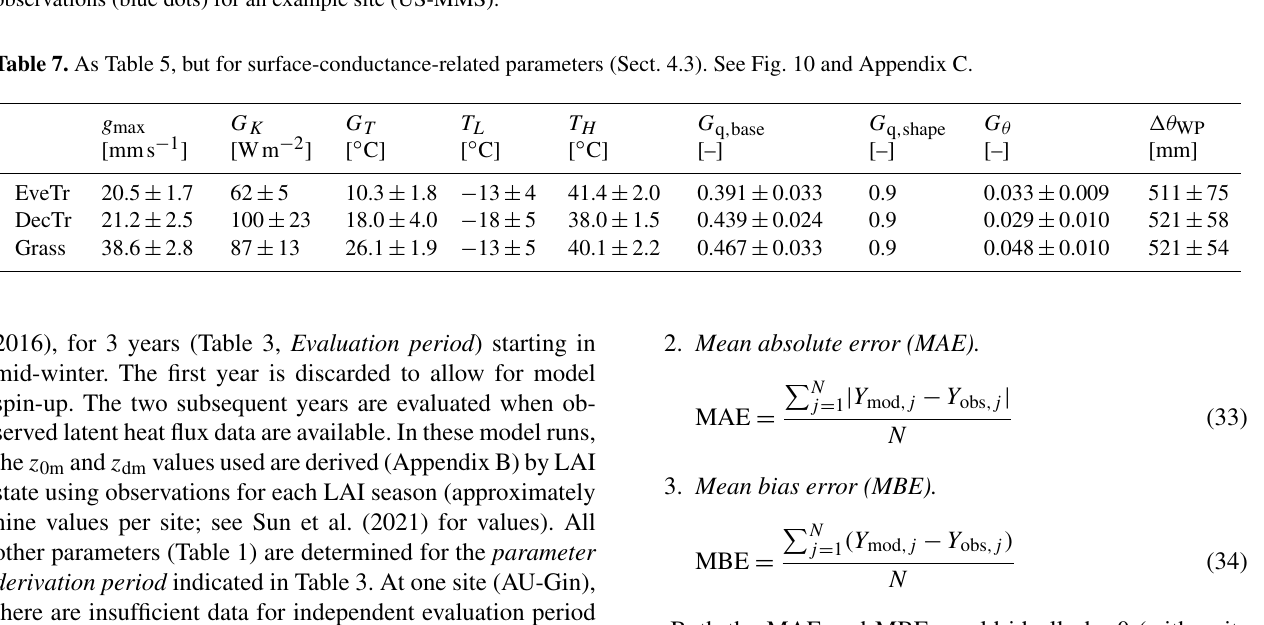
Figure 9. Derived relations (blue lines) between normalised surface conductance ˜ g s and (a) incoming solar radiation K ↓ , (b) air temper- ature T a , (c) specific humidity deficit (cid:49)q , and (d) soil moisture deficit (cid:49)θ based on anchor data points (red dots) after bootstrapping of observations (blue dots) for an example site